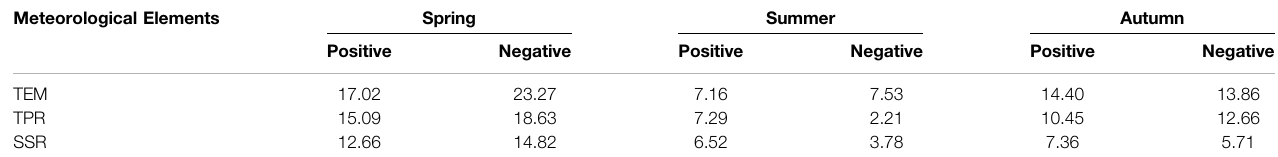
TABLE 1 | Proportion of vegetated areas with vegetation coverage signi fi cantly related to meteorological elements in China. Meteorological Elements